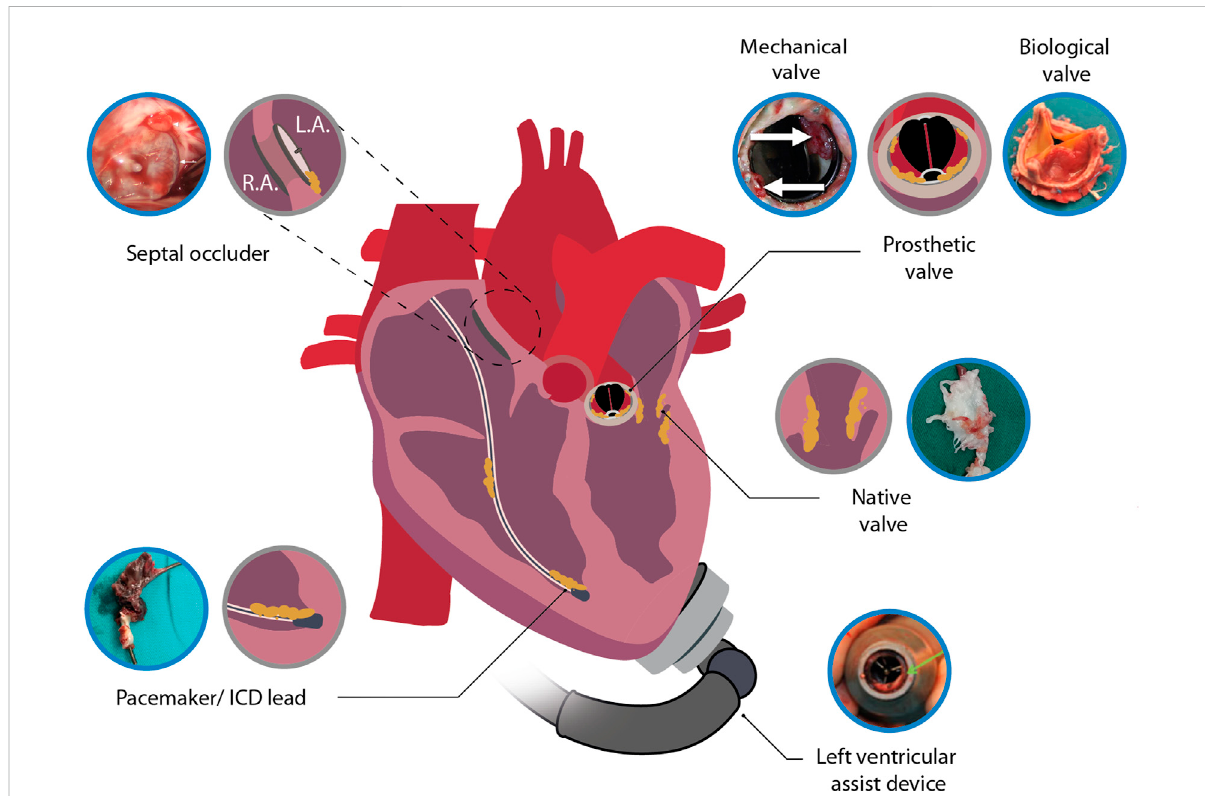
FIGURE 1 Illustrationdepictinginfectiveendocarditisassociatedwithnativehearttissueandcardiacdevices.Includedimagesareexamplesofaninfected septal occluder (Nguyen et al., 2016), mechanical heart valve (Pettersson et al., 2014), biological prosthetic heart valve (Jainandunsing et al., 2014), native heart valve (Li et al., 2022), LVAD (Akin et al., 2018) and pacemaker lead (Boljevic et al., 2019). Blue encircled images were adapted with permission from the original publishers and used as examples. L.A., left atrium; R.A., right